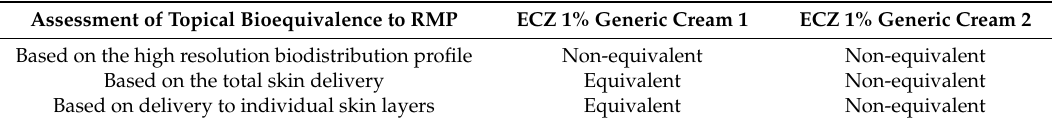
Table 3. Summary of bioequivalence assessment based on di ff erent information extracted from the results (wide acceptance